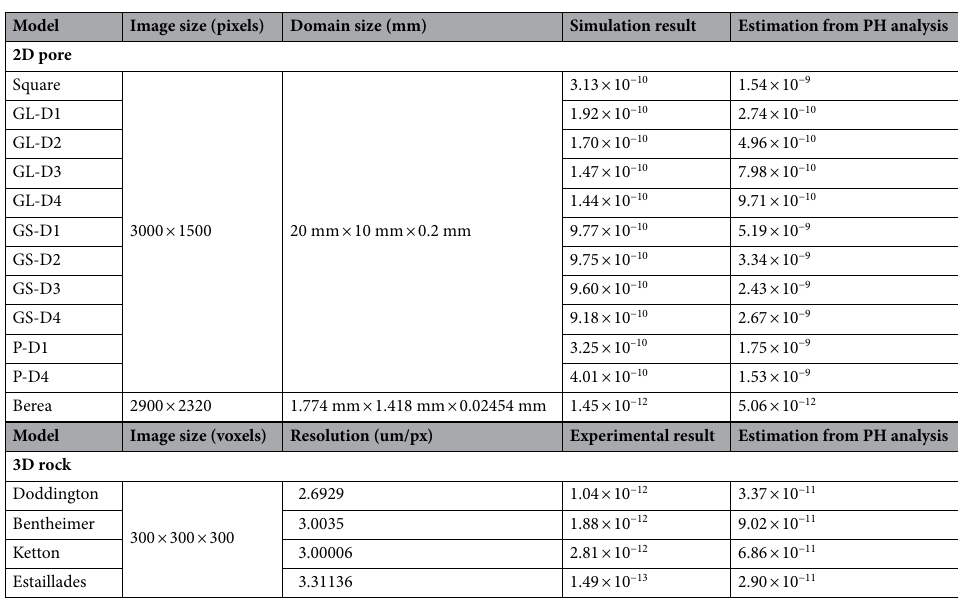
Table 3. Information of 2D pore 39 and 3D rock images 40 and their permeability. The correlation coefficients between the simulation results and estimations from persistent homology analysis for 2D pore models and 3D rock models were 0.887 and 0.764,